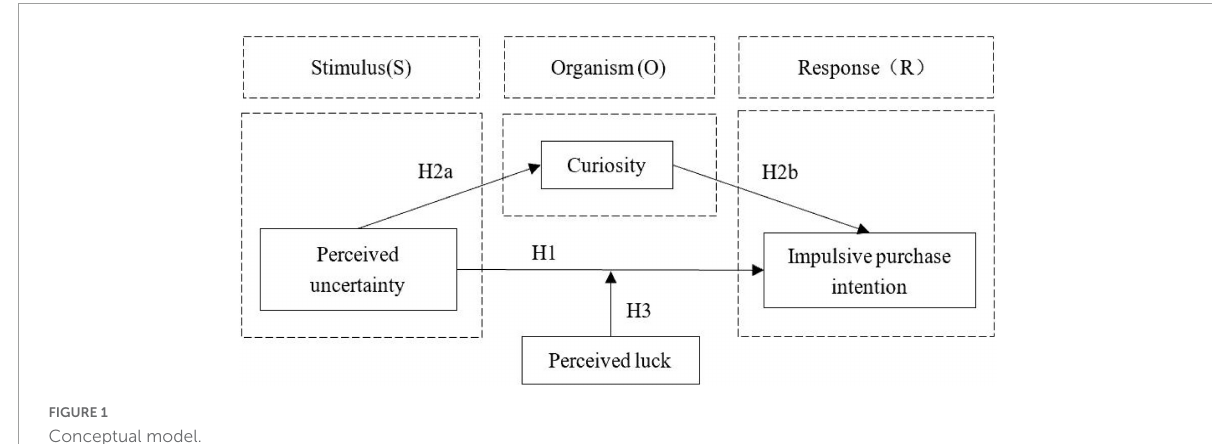
FIGURE1 Conceptual model.